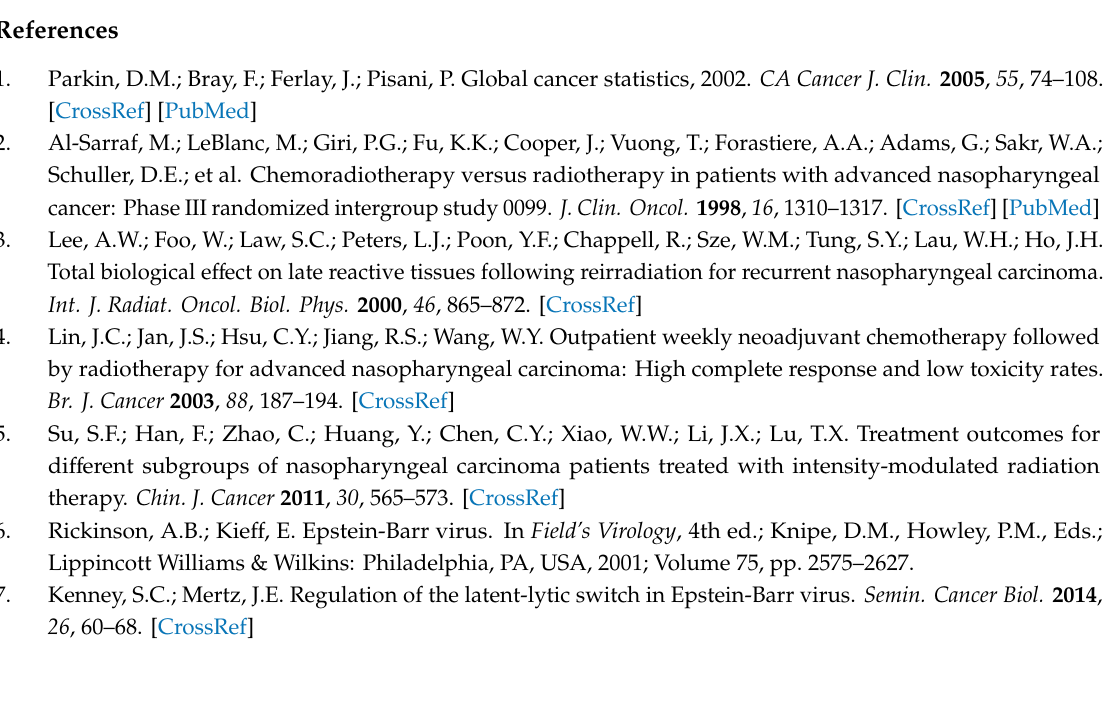
Figure S1: The original western results and band densitometry by Image J of Figure 2a, Figure S2: The original western results and band densitometry by Image J of Figure 2b, Figure S3: The original western results and band densitometry by Image J of Figure